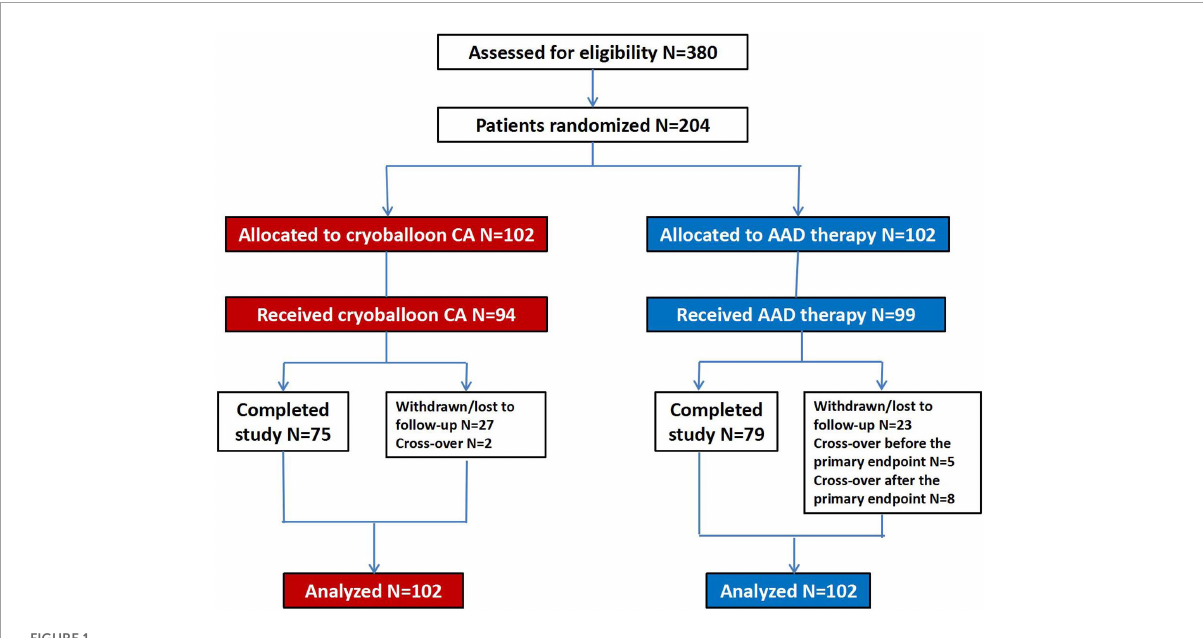
FIGURE1 Patient flow diagram. CA, catheter ablation; AAD, anti-arrhythmic drug.